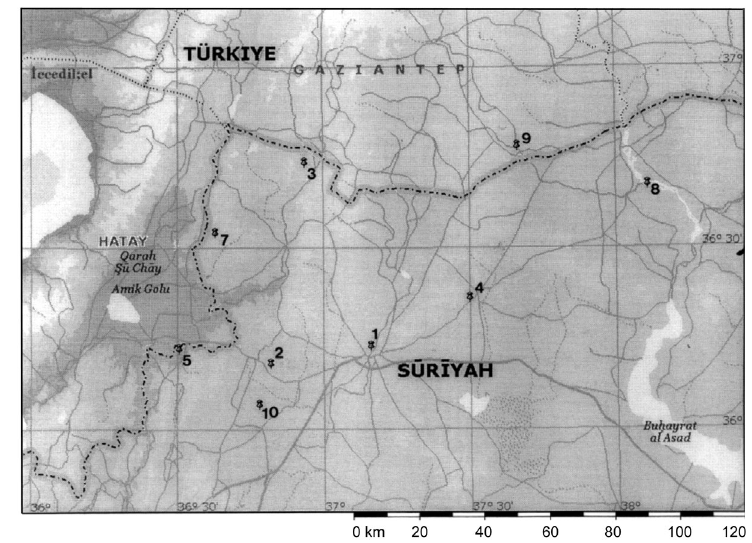
Fig. 3. Location map of the earthquake of 1138. 1 – Aleppo; 2 – Atharib; 3 – Azrab; 4 – Bizza; 5 – Harim; 6 – Raqqa (120 kn SE of Tell Amar); 7 – Shih; 8 – Tell Amar; 9 – Tell Khalid; 10 –